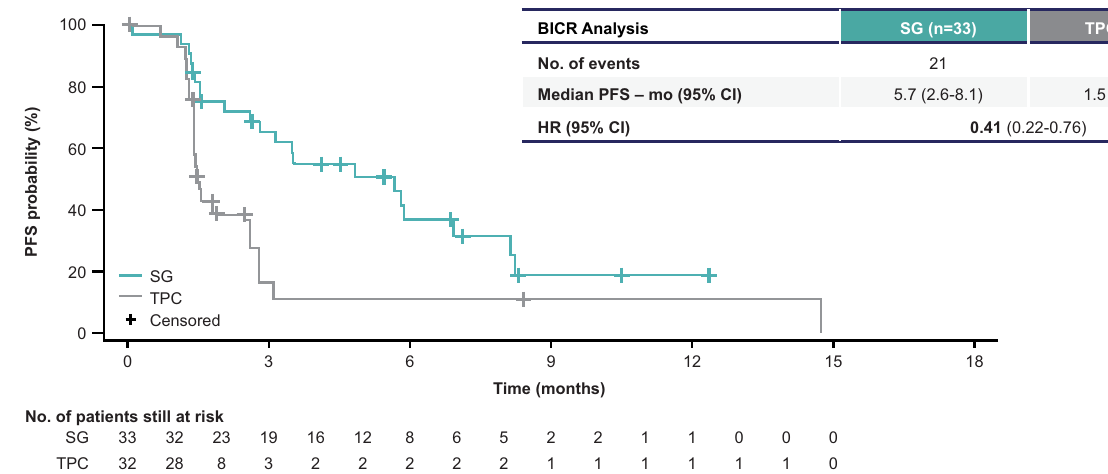
Fig. 1 Progression-free survival in the second-line subgroup. Assessed by independent central review in the brain metastasis-negative population. Second-line patients were de fi ned as those who received one line of therapy in the metastatic setting and recurred ≤ 12 months after (neo)adjuvant chemotherapy, prior to study enrollment. BICR blinded independent central review, HR hazard ratio, (neo)adjuvant neoadjuvant or adjuvant, PFS progression-free survival, SG sacituzumab govitecan, TPC treatment of physician ’ s